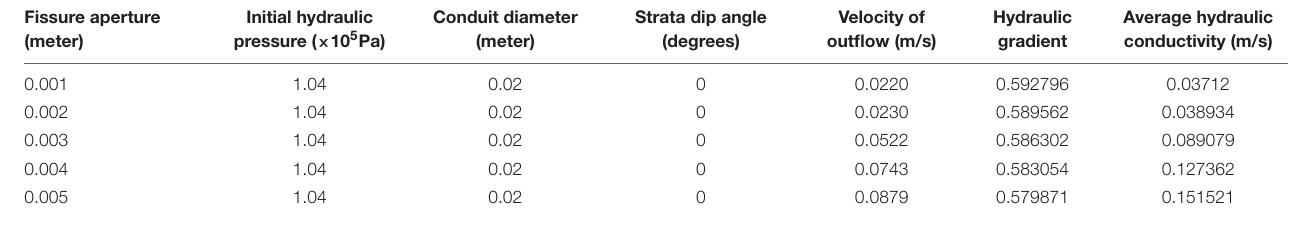
TABLE 7 | The simulation results while varying fissure